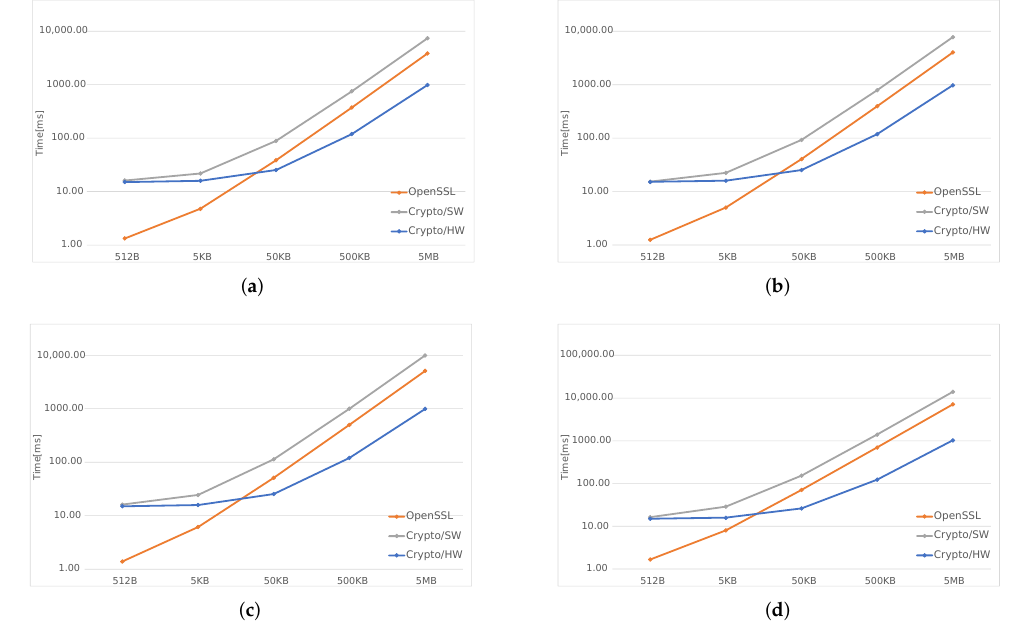
Figure 4. Time required to compute each SHA3 algorithm on increasing file sizes. ( a ) SHA3-224. ( b ) SHA3-256. ( c ) SHA3-384. ( d )